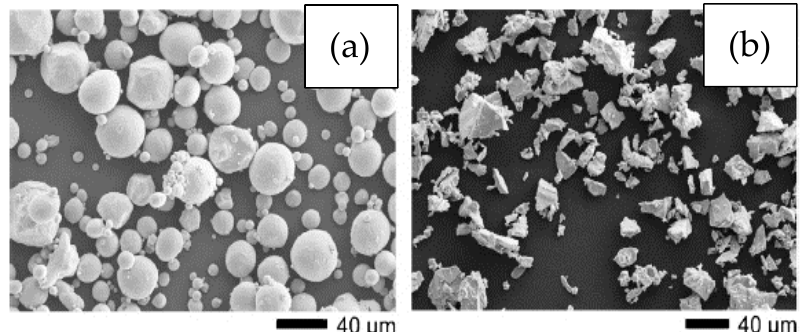
Figure 2. SEM images showing the morphology of ( a ) gas-atomized titanium powder, ( b ) hydride– dehydride (HDH) titanium powder. Adapted and reproduced with permission [28]. Copyright 2014, Elsevier.